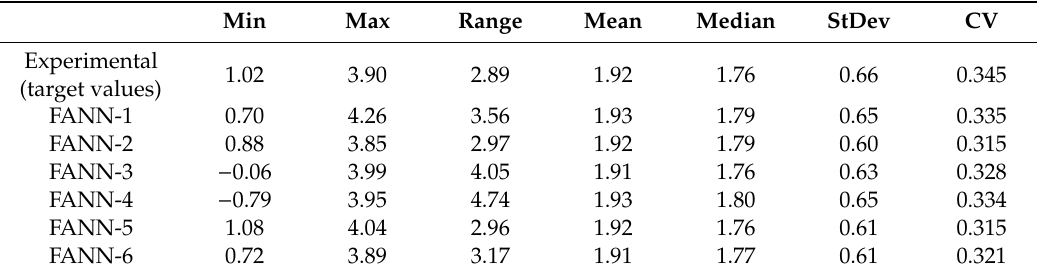
Table 7. Performance of the di ff erent ANN models for strain (values of ε cc / ε co ) on the training data set. Min Max Range Mean Median StDev CV Experimental 1.38 17.27 (target values) EANN-1 0.64 EANN-3 0.63 18.96